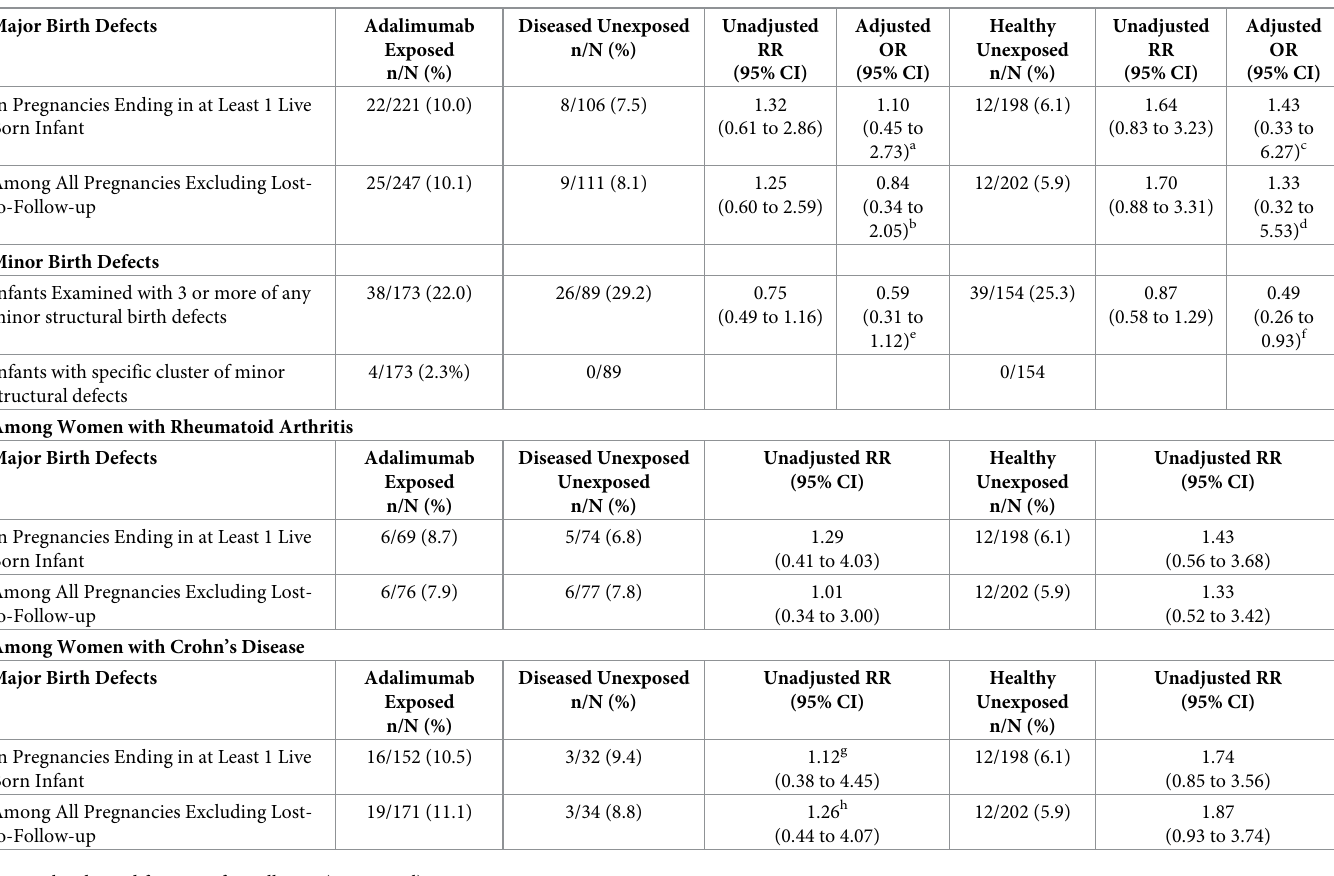
Table 3. Birth prevalence of major structural birth defects in pregnancies exposed to adalimumab compared to unexposed pregnancies,